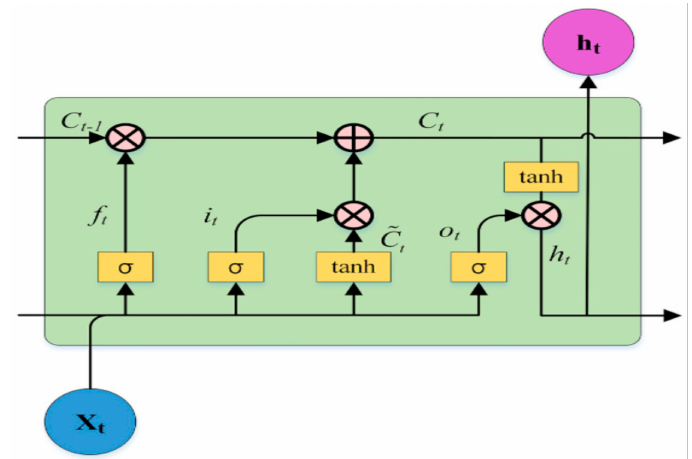
Figure 6. The LSTM cell unit. Copyright © 2021 Elsevier